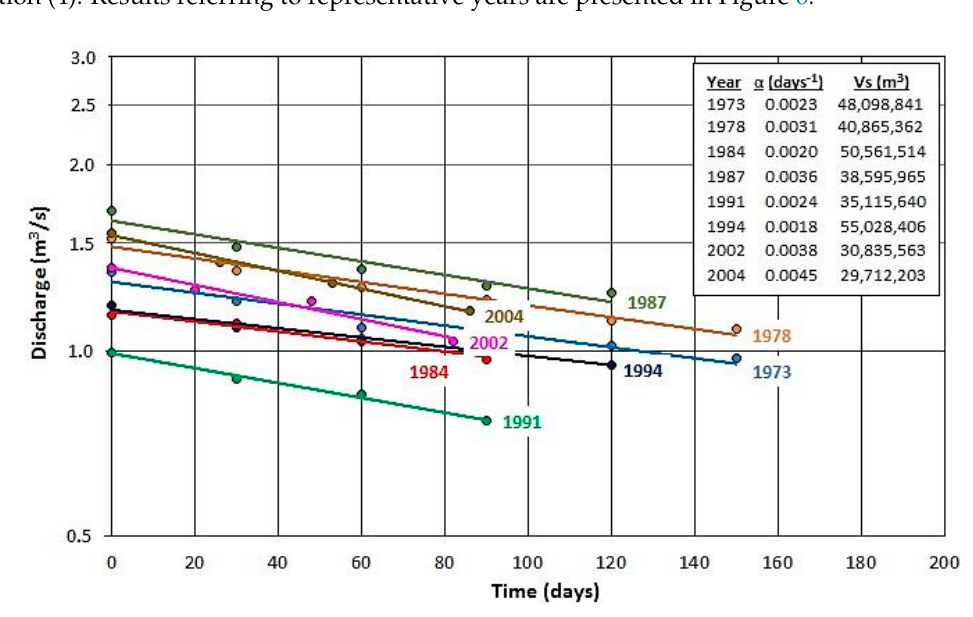
Figure 6. Discharge hydrographs of Kourtaliotis spring; values of its discharge coefficients ( α ); and dynamic reserves (V S ).